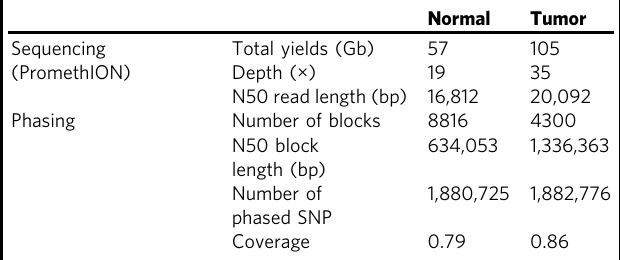
Table 1 A summary of the phasing analysis performed on case